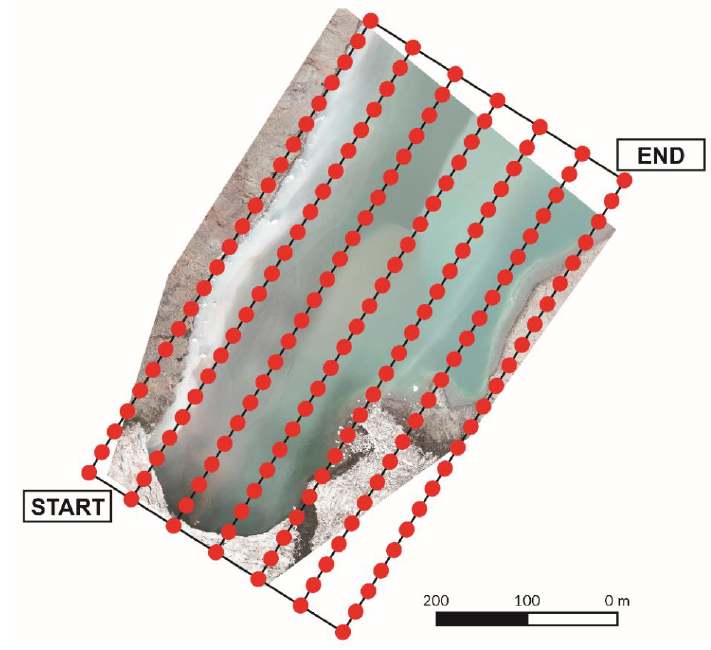
Figure 5. Flight plan example showing image waypoints and flight lines on the Zalewski Glacier.